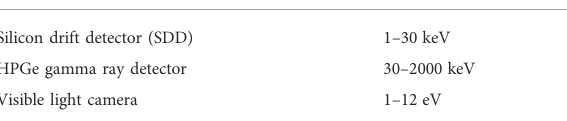
TABLE 1 Diagnostics for electron temperature measurement on